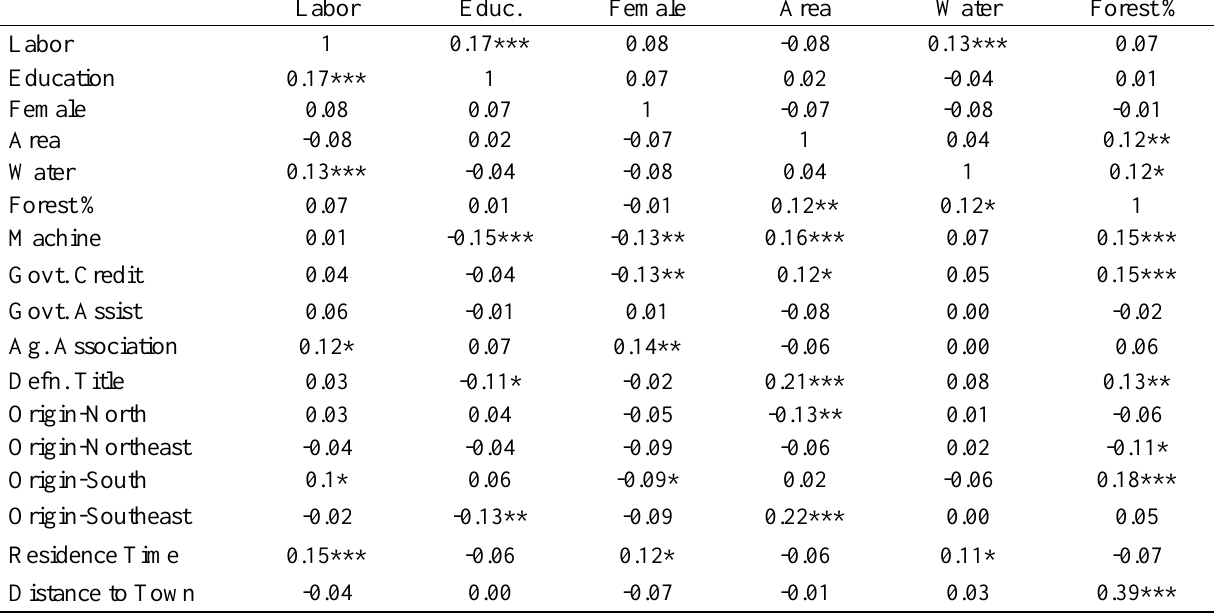
Table A3.1: Correlation table for all explanatory variables analyzed in this study. Labor Educ. Female Area Water Forest %